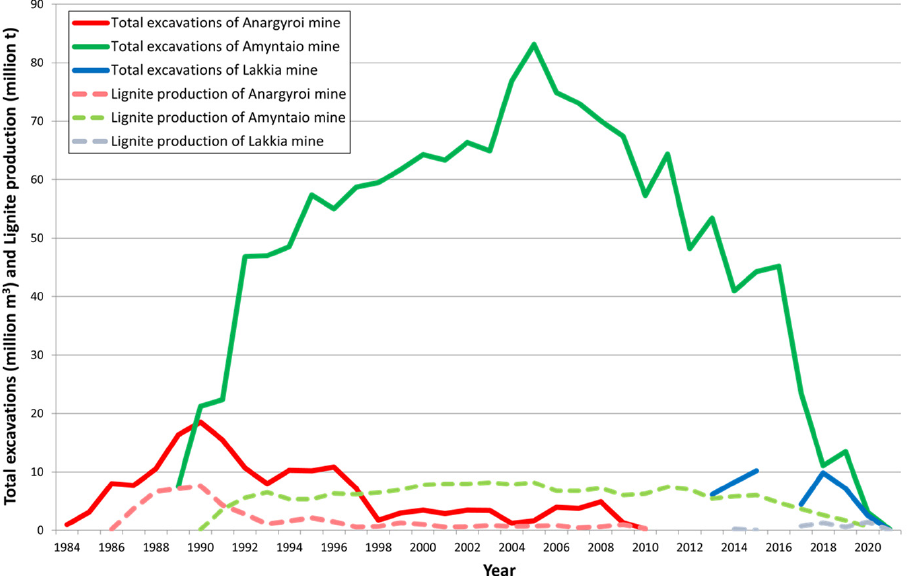
Figure 4. Total excavations (full lines) and lignite production (dashed lines) of the Amyntaion area mines per year. The green line corresponds to the case study (Amyntaion mine).